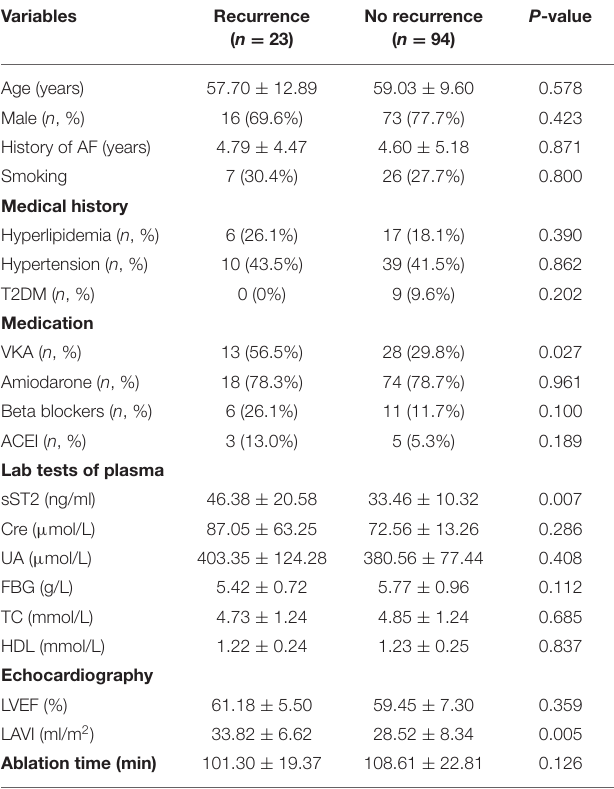
TABLE 2 | Clinical characteristics in persistent AF patients.